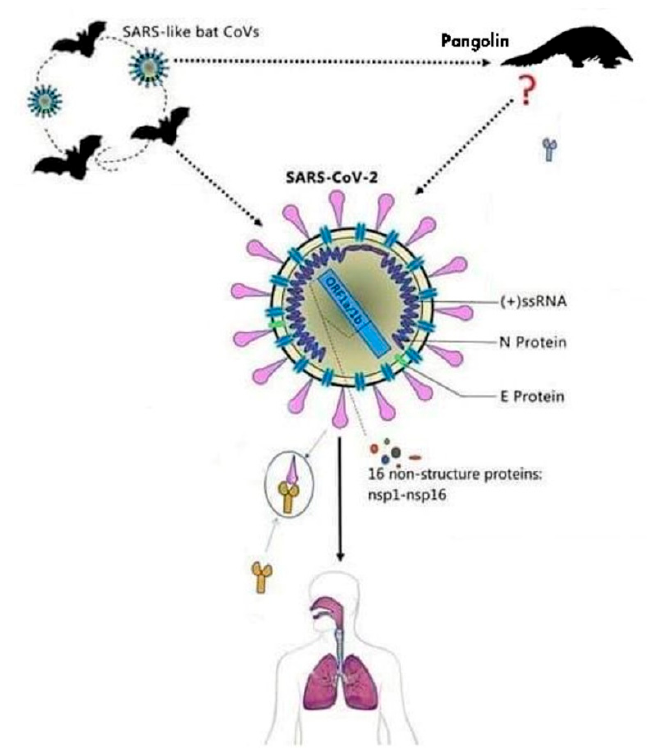
Figure 2. Conformation of SARS-CoV-2 (figure drawn by Giovanna Dipalma).